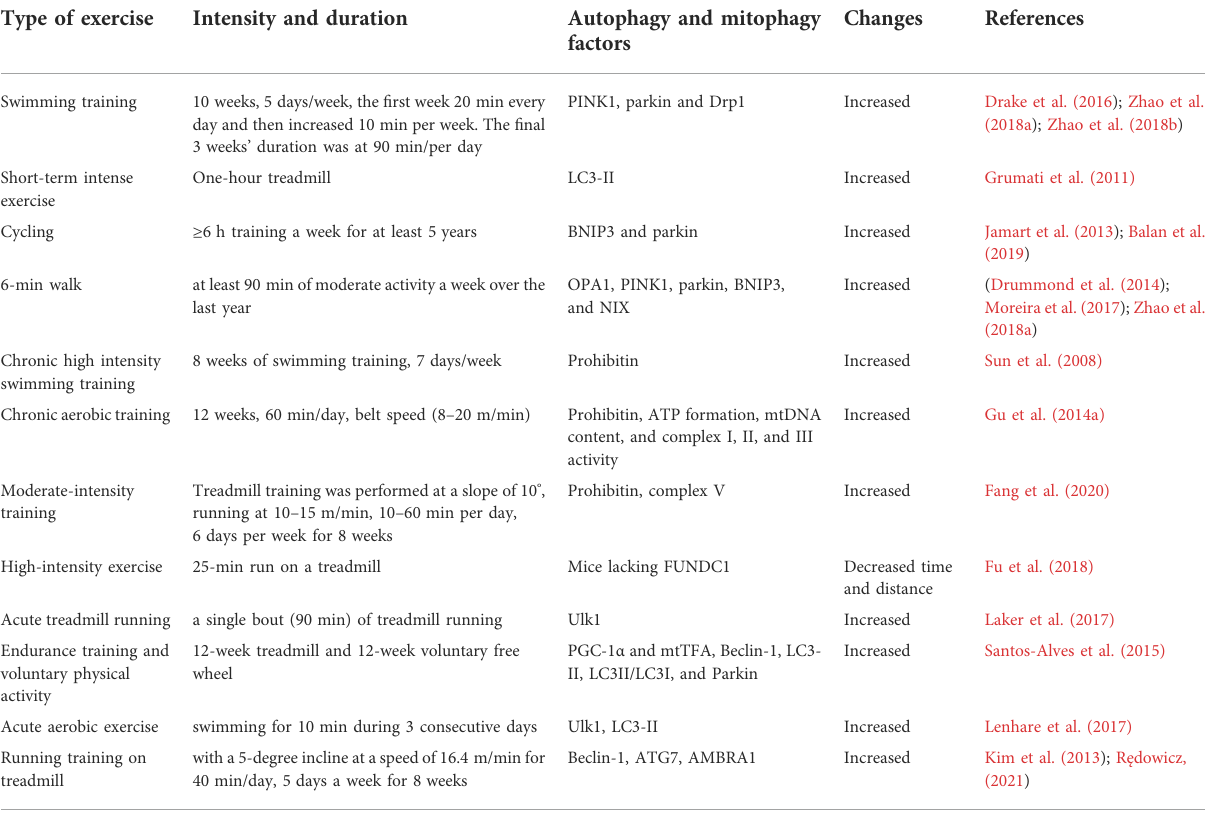
TABLE 1 A summary of exercise studies on the factors affecting autophagy and